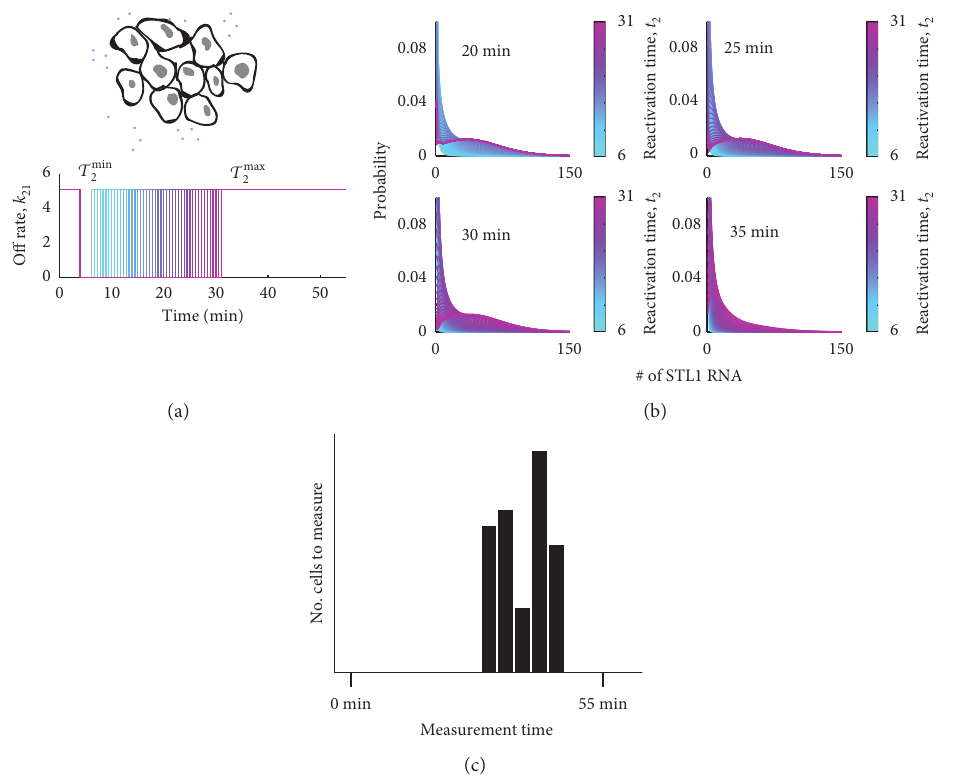
Figure 5: Overview of optimal design for biosensing experiments for the osmotic stress response in yeast. (a) Unknown salt concentrations (purple dots) in the environment give rise to different reactivation times, τ k . These different reactivation times cause downstream STL 1 expression dynamics to behave differently as shown in (b). (c) Different 21 responses can be used to resolve experiments that reduce the uncertainty in τ